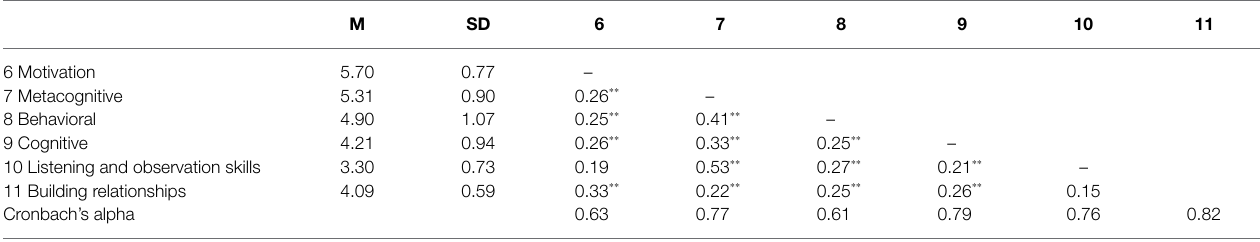
TABLE 3 | Correlations between cultural intelligence and intercultural competence dimensions. M SD